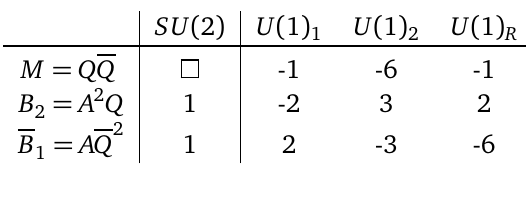
Table 5: Global quantum numbers of gauge invariant composite fields for F =